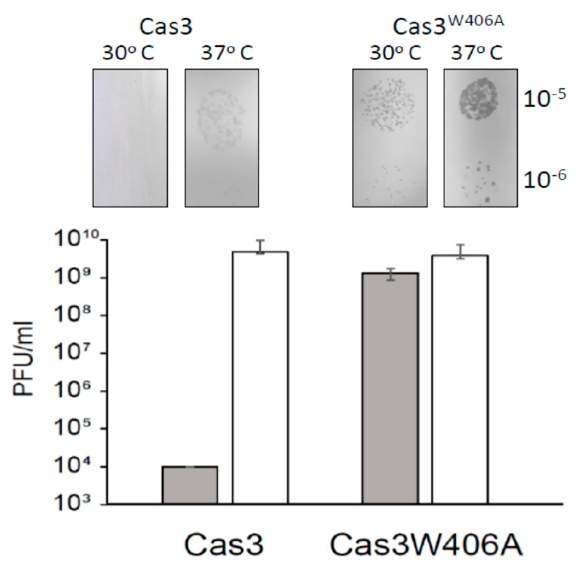
Figure 5. The allele cas3 W406A does not provide resistance to λ vir at 30 ◦ C. E. coli cell lawns of strain ∆ hns ( ∆ cas1 ) + λ c + λ T3 (IIB1309) and cas3 W406A ∆ hns ( ∆ cas1 ) + λ c + λ T3 (IIB1342) were infected with phage dilutions (from 10 − 3 to 10 − 7 ) and incubated at 30 ◦ C and 37 ◦ C as indicated. Bars represent average and SD of the number of plaque forming units (PFUs) per ml from three independent experiments. Also shown are corresponding photographs of typical bacterial lawns and viral plaques giving the data.